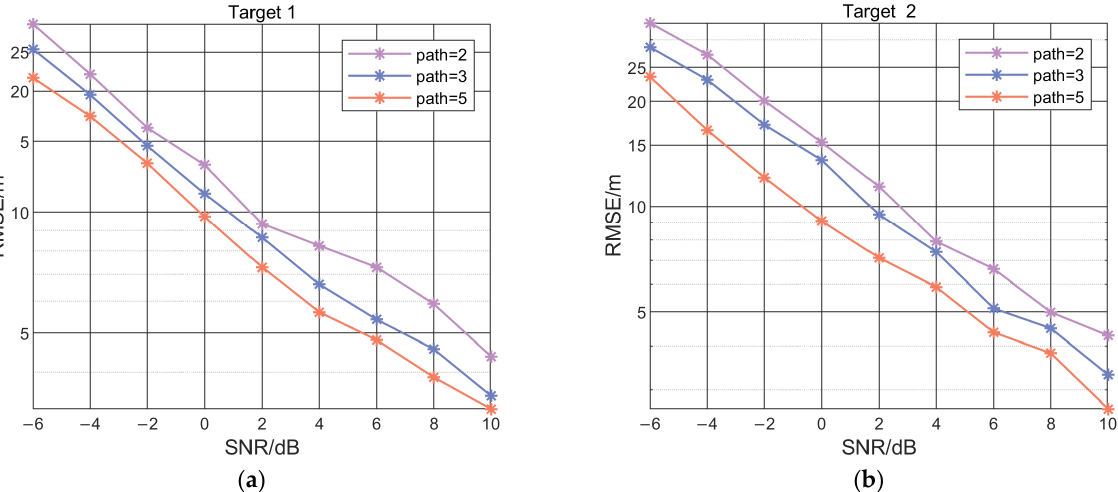
Figure 8. IFLA Localization performance comparison with different numbers of signal propagation paths (path) for target 1 ( a ) and target 2 ( b ).